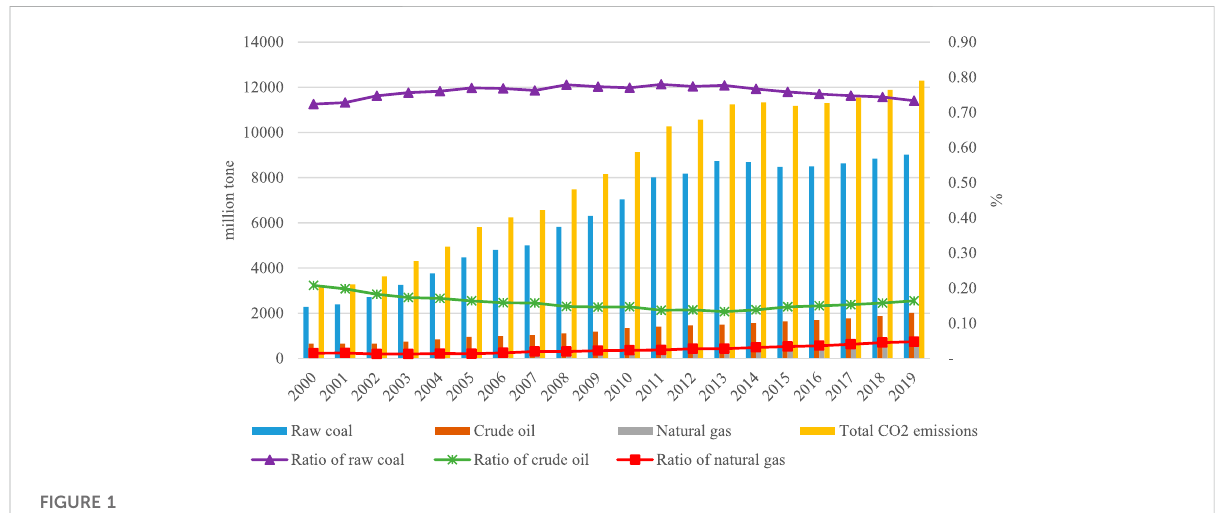
FIGURE 1 The structure of carbon emissions in China from 2000 to 2019 1